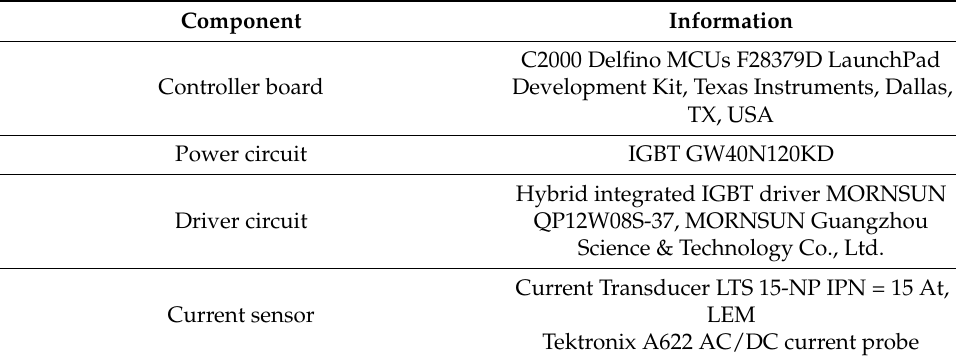
Figure 29. Experimental prototype for the test of the DSA-PSC and the DSA-LSC methods. Table 7. Information on experimental components.